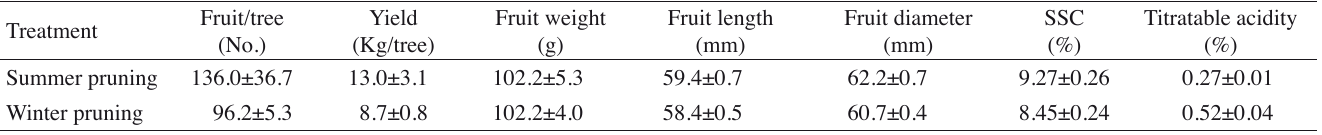
Table 1 - Effect of summer pruning on peach fruit yield and quality in the following season (2001) Treatment